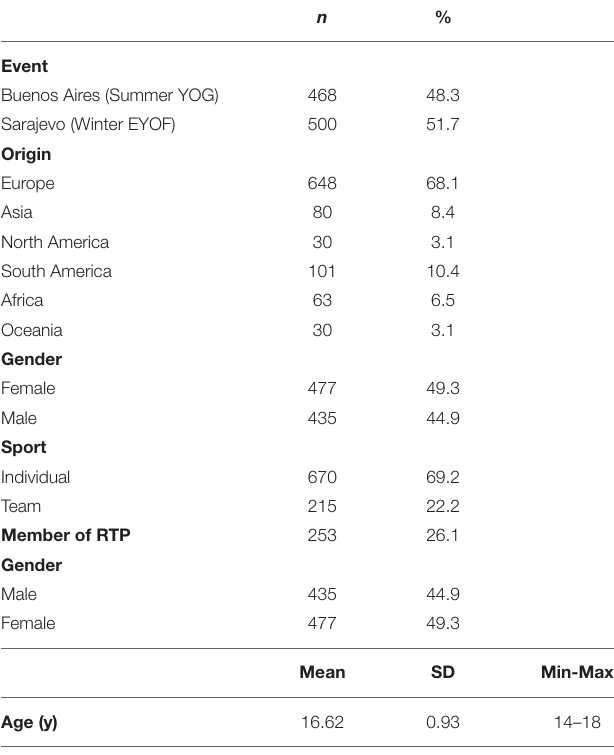
TABLE 2 | Socio-demographic characteristics of the study cohort—phase one.